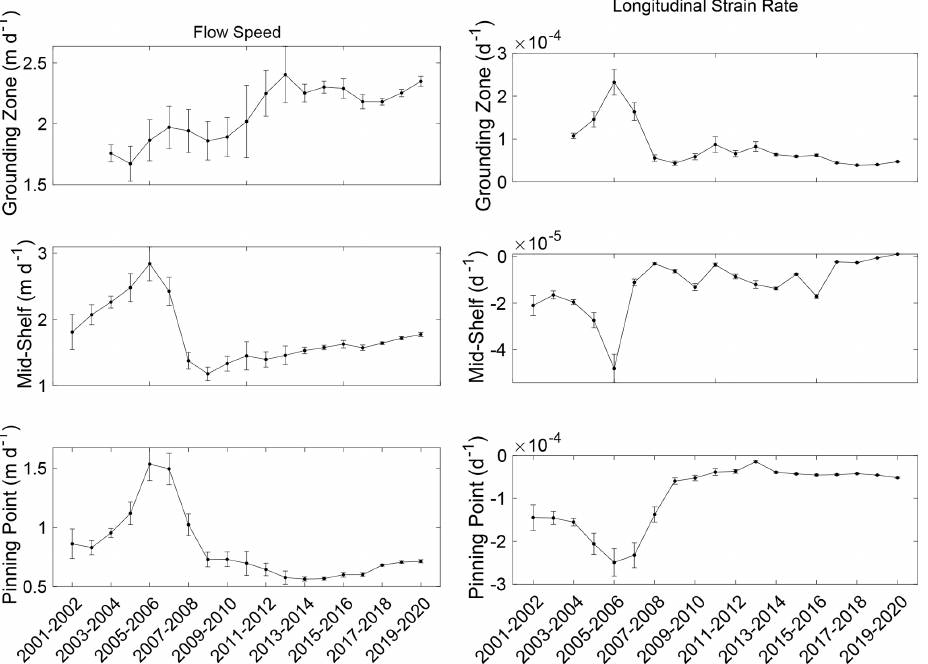
Figure 5. Average values of speed, flow direction, and longitudinal strain rate at the three sites of interest (locations shown in Fig. 1) for the 5-year velocity record.